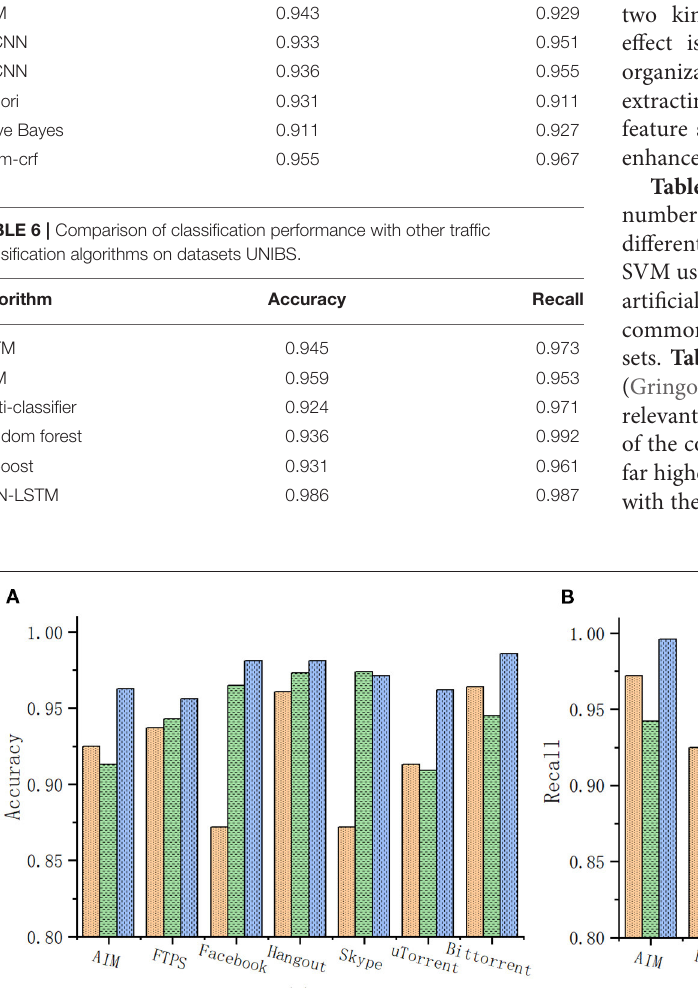
Frontiers in Neurorobotics |